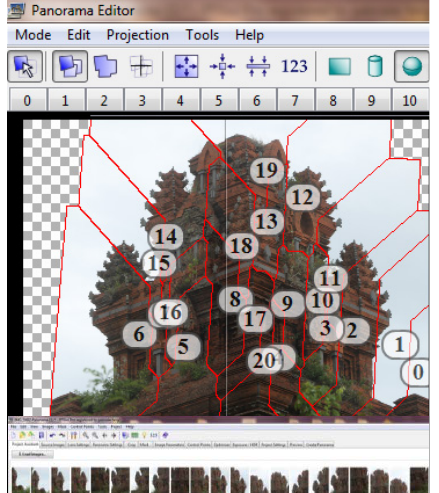
Figure 2. Image gallery and panorama editor (PTGui software)